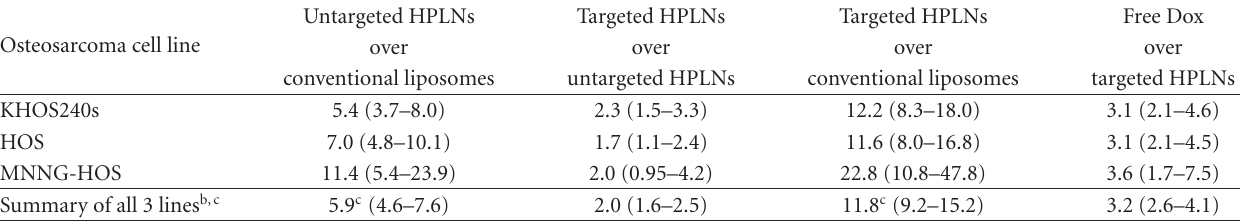
Table 1: Relative cytotoxic potency of doxorubicin-loaded vehicles: ratio of (IC50) − 1 between vehicles summarized by geometric mean (95% confidence interval) a